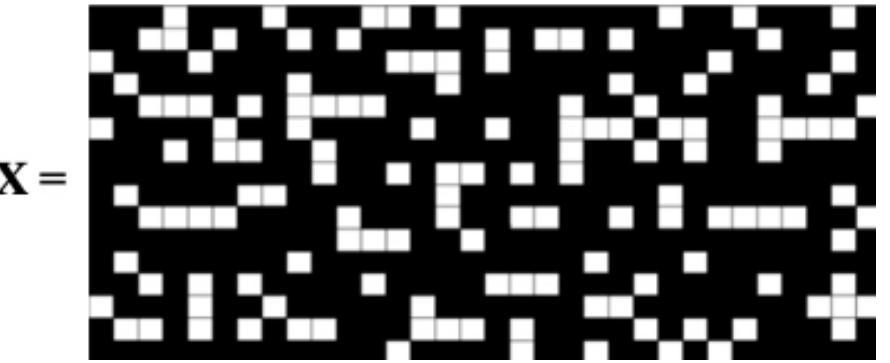
Figure 1. Partially annotated characteristics